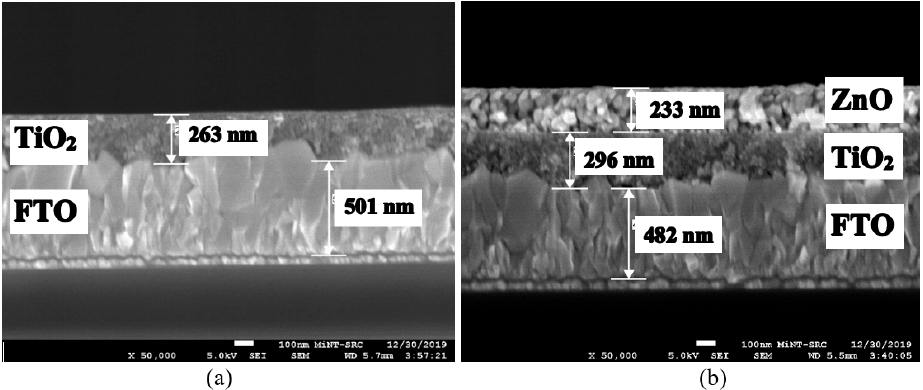
Figure 4. FE-SEM cross-sectional images of ( a ) the n-TiO 2 /FTO substrate annealed at 600 °C for 1 h